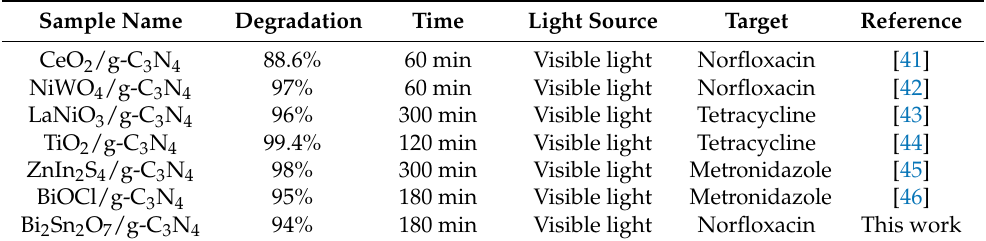
Table 2. Comparison of photocatalytic performance with other g-C 3 N 4 based heterojunction